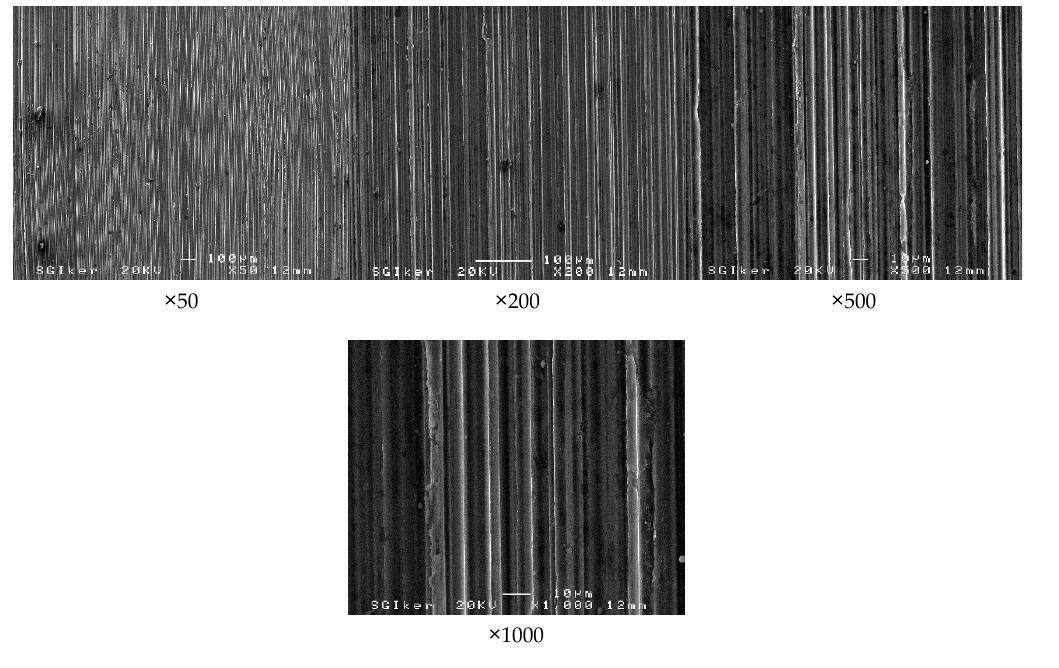
Figure 14. AA-5083-F380 disk. Figure 14. AA ‐ 5083 ‐ F380 disk. Figure 14. AA ‐ 5083 ‐ F380 disk.